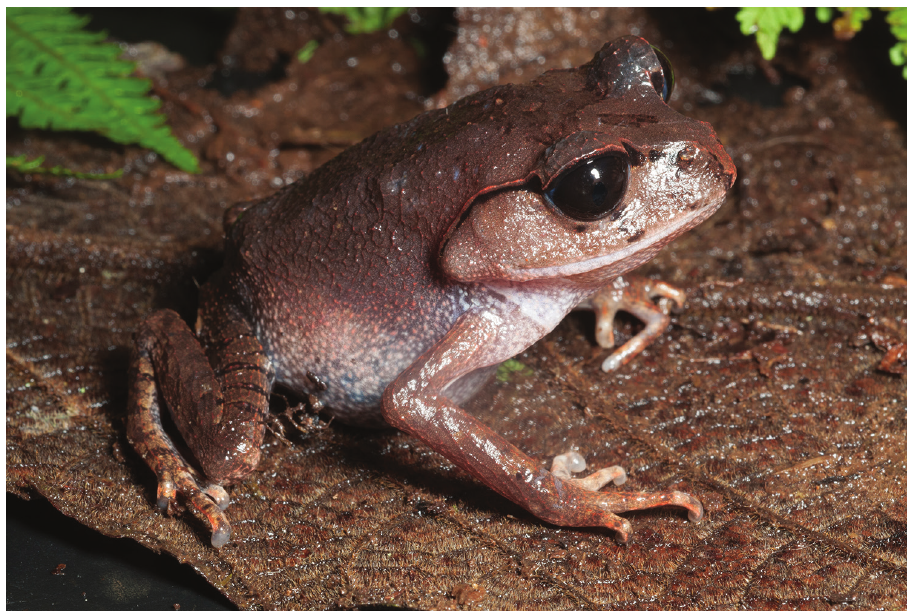
Figure 17. Leptobrachium lumadorum male (KU 334801) from 1200 masl, Shrine Site, Mt. Lumot, Municipality of Gingoog, Misamis Oriental Province. Photo: